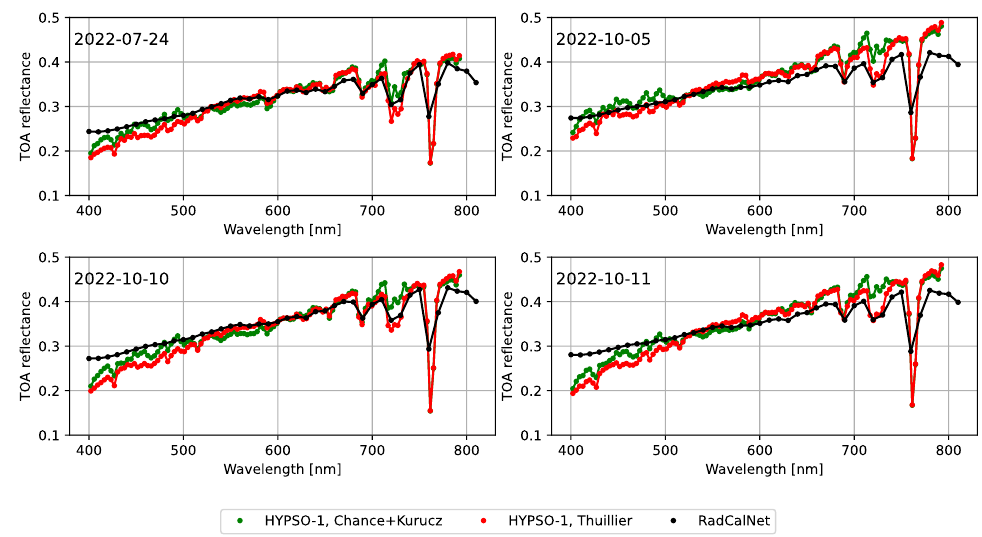
Figure 12. ToA reflectance spectral comparison of HYPSO-1 and RadCalNet calibration site Railroad Valley Playa. The date of each capture is stated in the top left. The HYPSO-1 ToA reflectance was calculated using the Chance+Kurucz solar spectrum and the Thuillier solar spectrum. See Table 7 for information on the geometry.